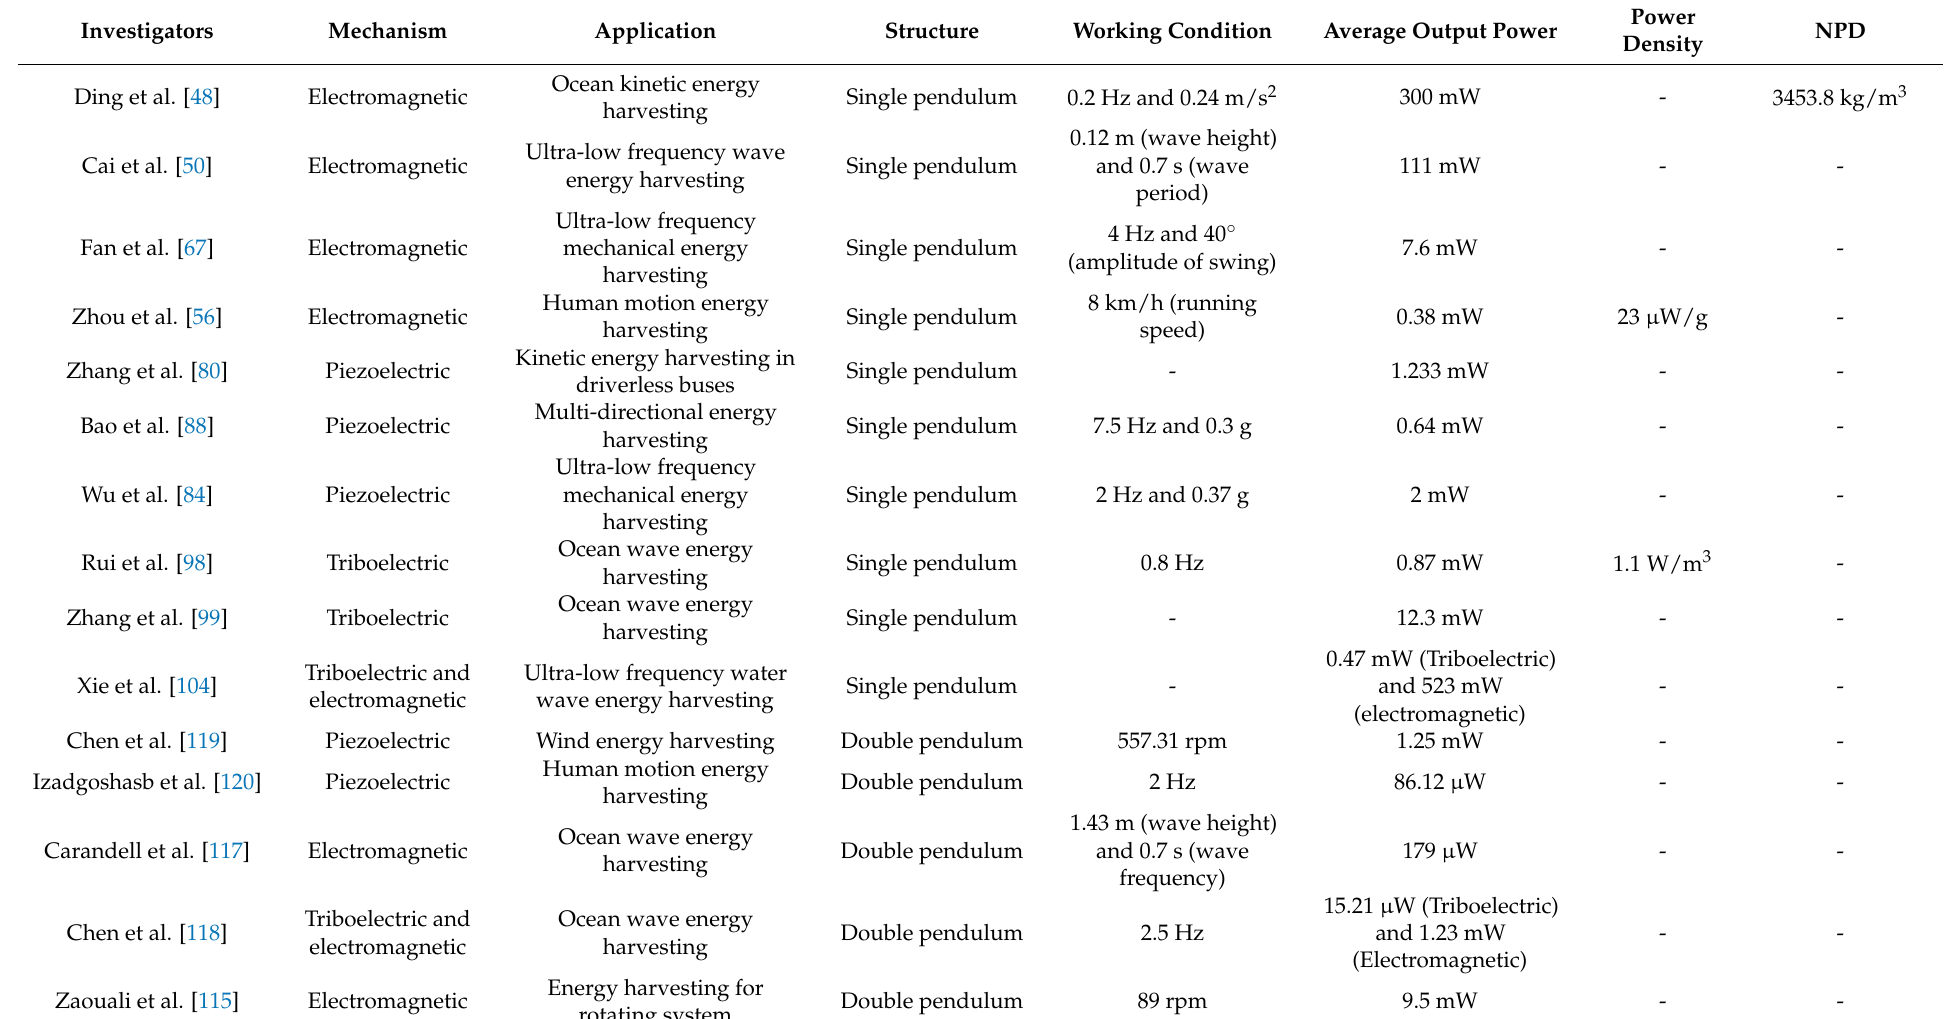
Table 1. Comparison of various energy harvesters based on pendulum